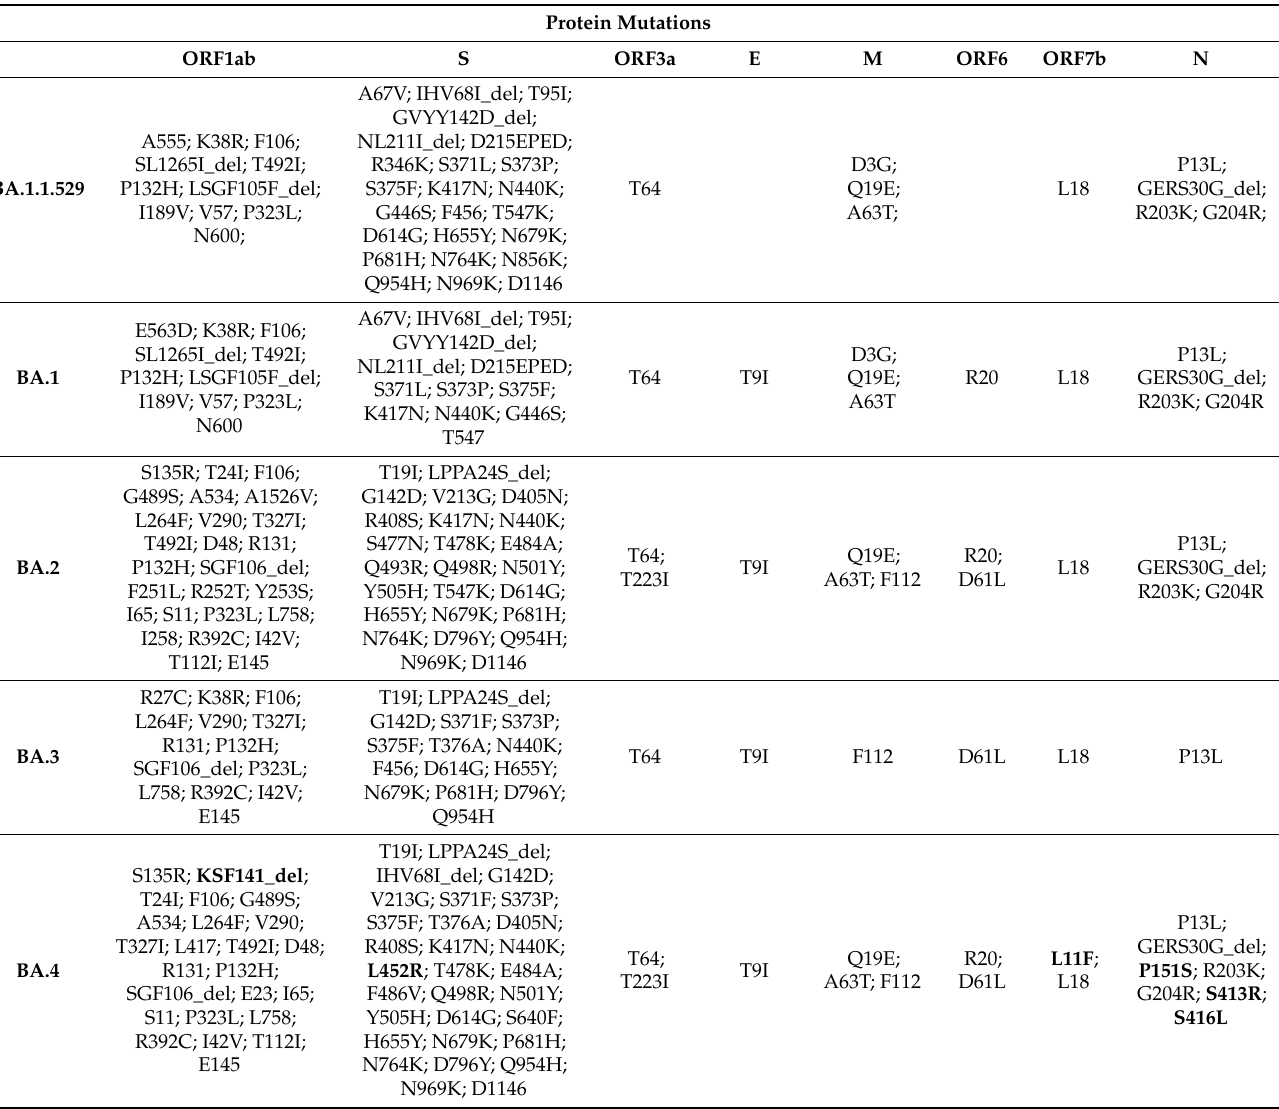
Table 1. Amino acid mutations in the genome of Omicron sub-lineages were obtained by whole- genome sequencing. Protein